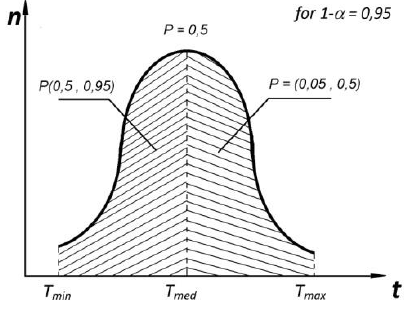
Fig. 1. Determination of durability using a’posteriori